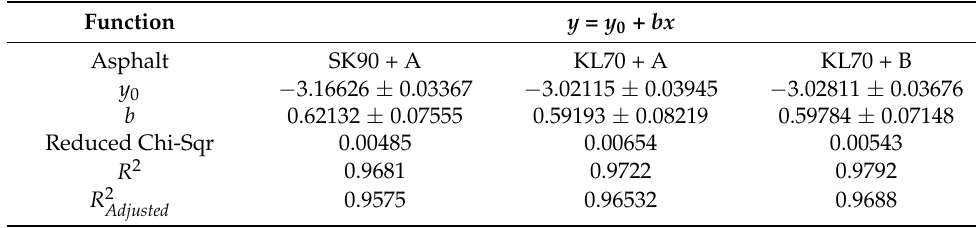
Figure 11. Relationship between log τ 0 of binder and the corresponding mastics ( a , b ). ( b ) is more observed compare with ( a ). Table 5. Fitting result of the relation between log τ and effective filler volume fraction.